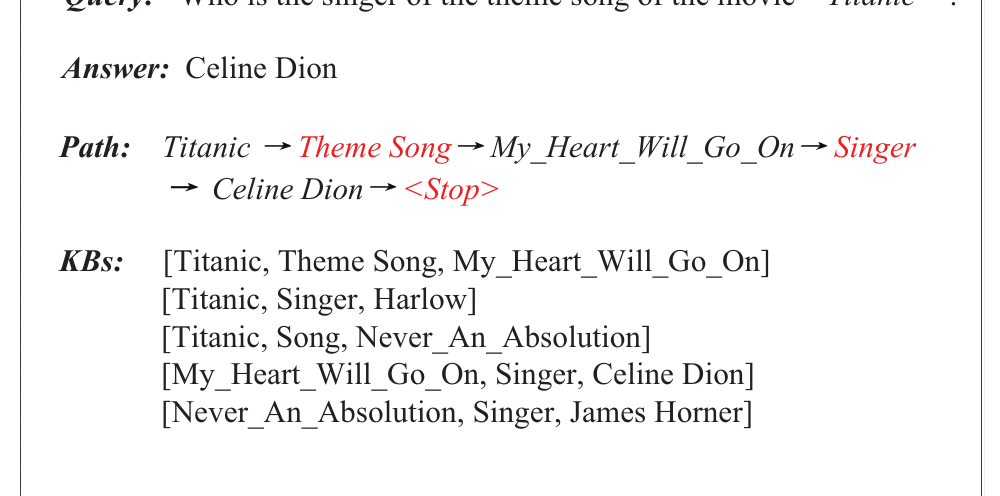
Figure 4. An exemplar of a two-hop query in a KBQA dataset; the figure shows the reasoning path and triples related to entities in the query, and graphically shows how the model reaches the answer to the question through the reasoning